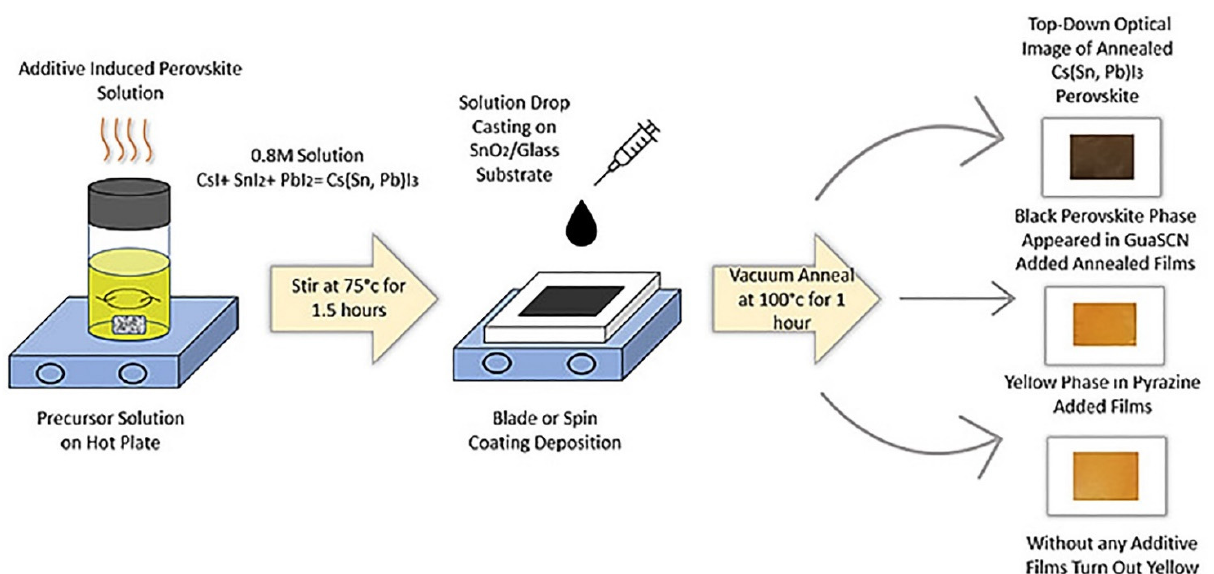
Figure 1. Chemical synthesis and solution processing of Cs(Sn, Pb)I 3 perovskite films with and without additives.